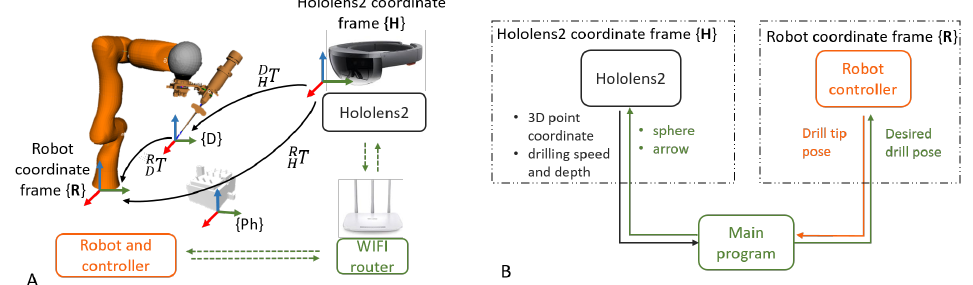
Figure 2. ( A ) System overview of the involved transformations and coordinate frames. The notation B T denotes the transformation from coordinate frame A to B. ( B ) A schematic overview of the A functional modules of the proposed